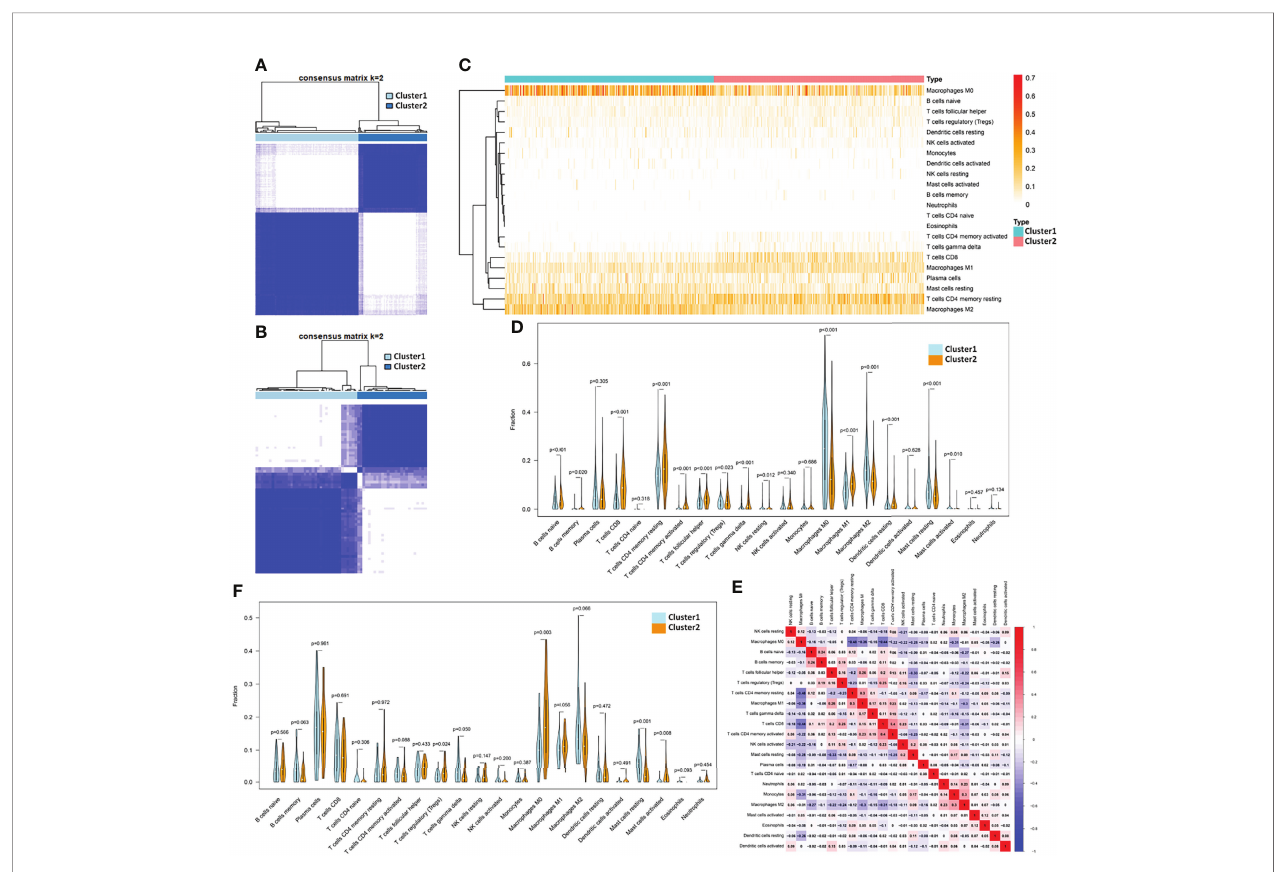
FIGURE 1 | Identi fi cation of subtypes by T H cells and the corresponding TIME in breast cancer. (A) The consensus matrix when k =2 through cluster analysis based on the expression of T H cell-related gene characteristics in 1,090 samples from TCGA database and (B) 64 samples from GSE31519 dataset. Heatmap (C) and violinplot (D) of the fraction of 22 kinds of immune cells in the TIME of the two clusters obtained from the TCGA database. (E) Heatmap of the correlation of 22 immune cell components obtained from the TCGA database. (F) Violinplot of TIME in the two clusters from the GSE31519